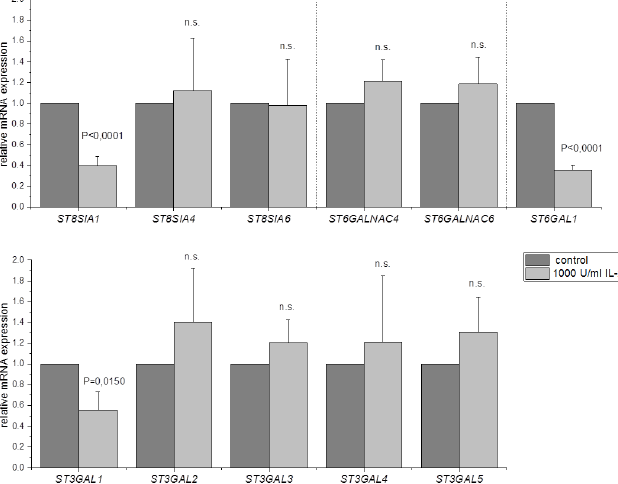
Figure 2. Expression of sialyltransferases in NK-92 cells after activation with IL-2. NK-92 cells were incubated without IL-2 for 24 h. Afterwards, cells were either left untreated (control) or treated with 1000 U/mL IL-2 for 4 h. cDNA was synthesized, and quantitative real-time PCR reactions were performed. Data were normalized to Beta-2 microglobulin ( B2M ) expression. Graphs show average mean ± SD of at least 3 independent experiments.